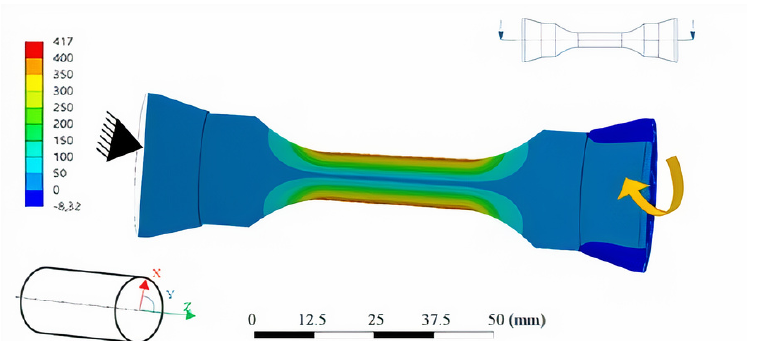
Figure 4. Sectional view depicting the shear stress inside the sample for 350 MPa compressive stress and 7.5°